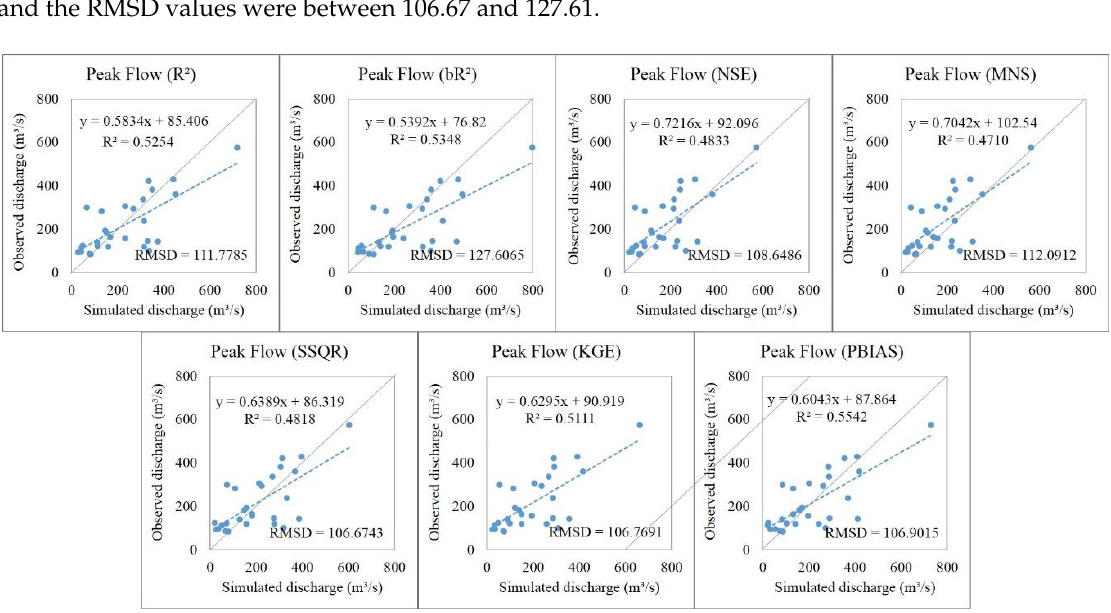
Figure 10. Scatter plots of simulated versus observed peak flows for different objective functions.